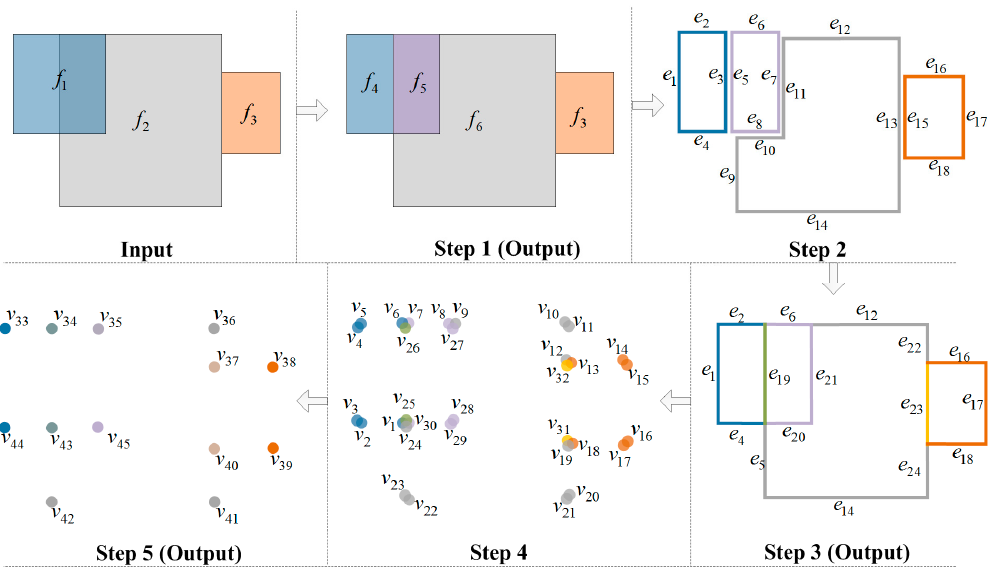
Figure 10. Process of generating all non-overlapping footprints.